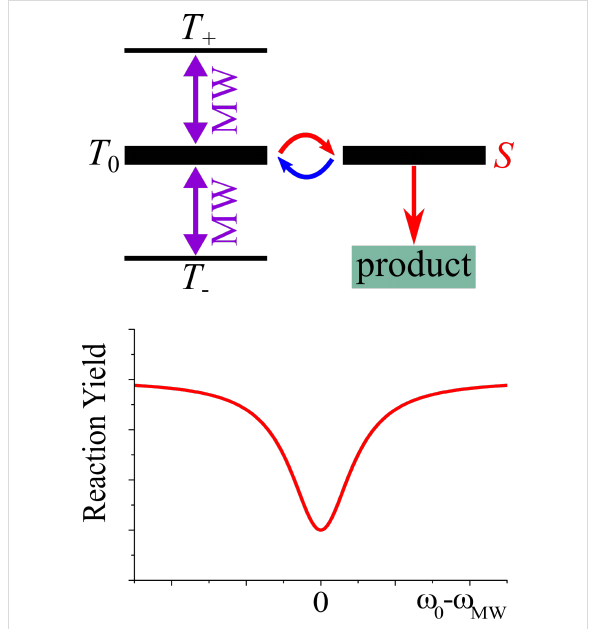
Figure 9: Principle of the RYDMR method. Top: reaction scheme – interconversion mixes the S and T 0 of a radical pair, which reacts from the S state. Hereafter, in the energy level diagram, the thickness of levels corresponds to the state population. A MW-field can drive the T 0 ↔ T + and T 0 ↔ T − transitions. Bottom: schematic representation of the RYDMR spectrum – the singlet-state population can be monitored by measuring the reaction yield as a function of the MW-frequency. When the MW-field is applied in resonance with the triplet transitions, T 0 ↔ T + and T 0 ↔ T − (i.e., the MW frequency is matched to ω 0 , which is the precession frequency of the SCRP partners), the populations of the S and T 0 states are decreased. The RYDMR signal can be obtained as a dip in the dependence of the reaction yield on the MW-frequency, ω MW . Experiments with MW-pulses with variable lengths and inter- pulse delays can be performed to obtain quantum beats and echo-like